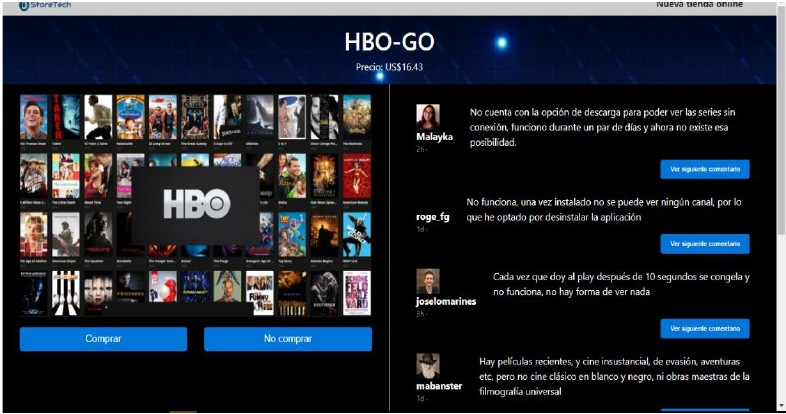
Figure A3. Opinion Leader’s recommendation example.